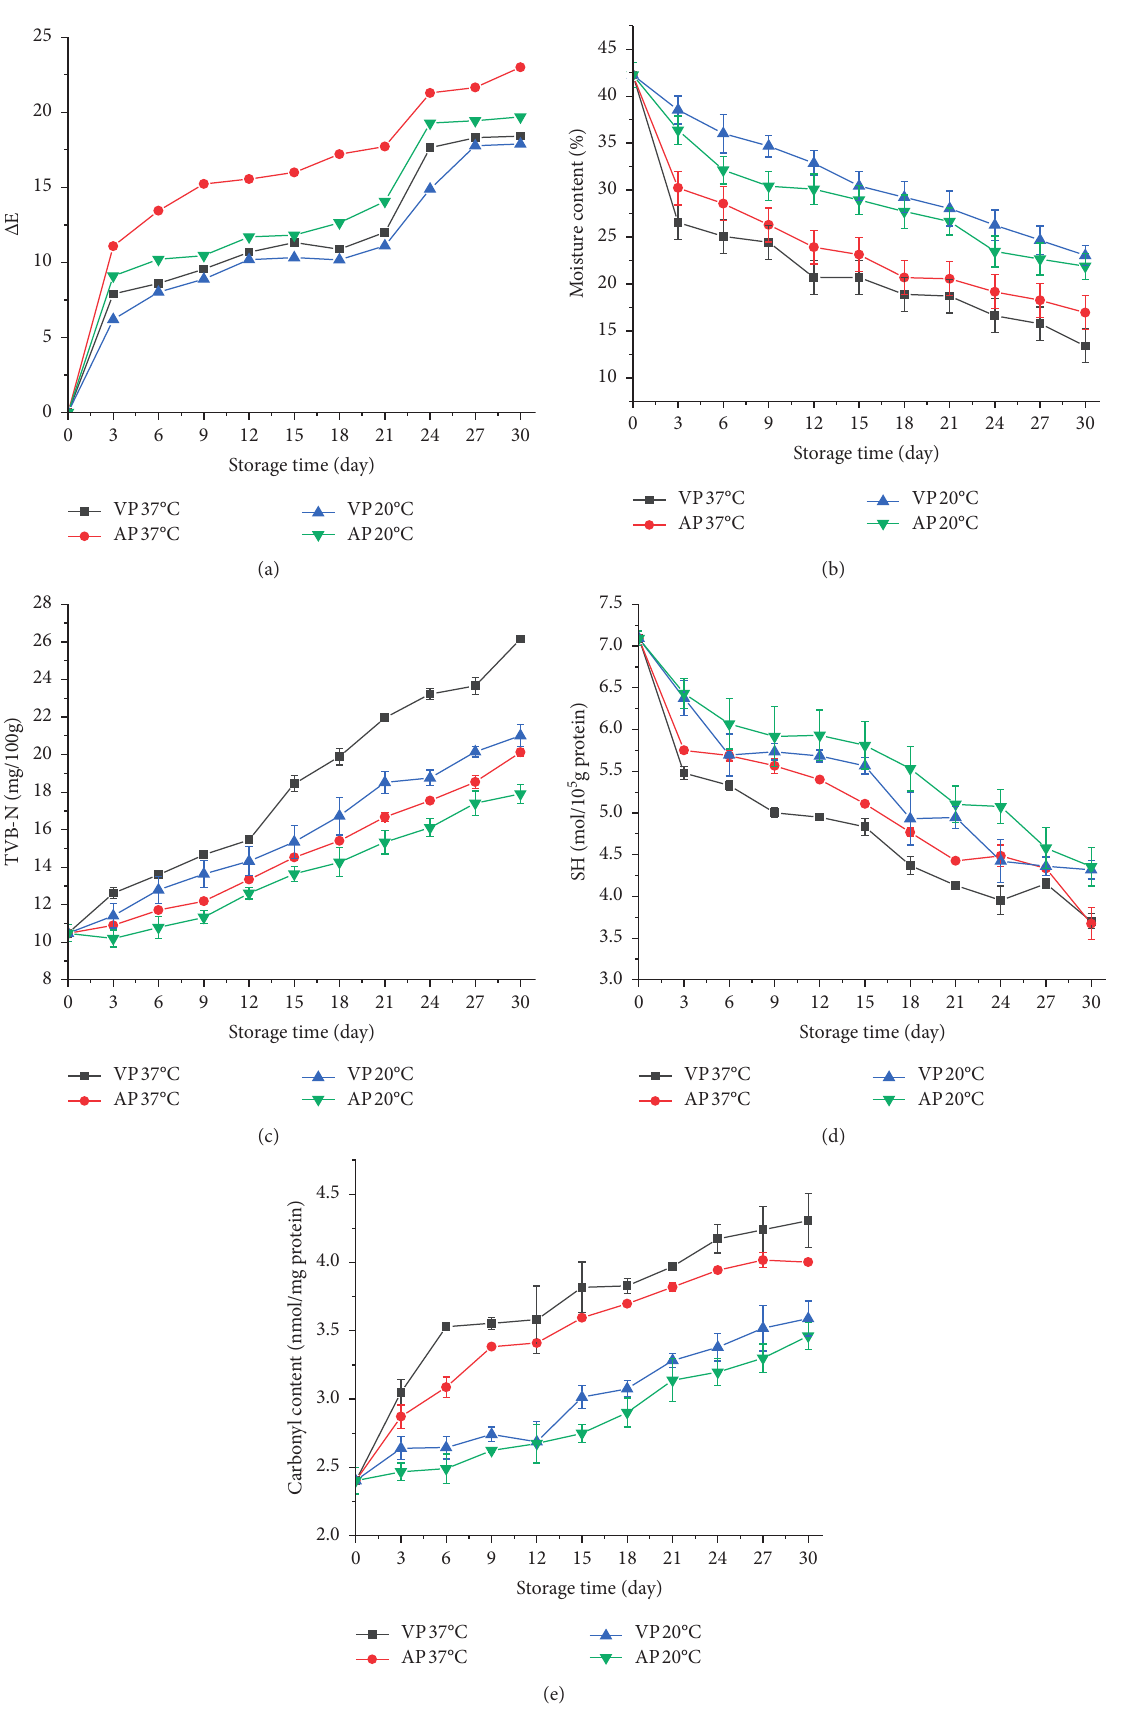
Figure 1: Variation in ∆ E (a), moisture content (b), TVB-N (c), SH (d), and carbonyl content (e) of dried shrimps during